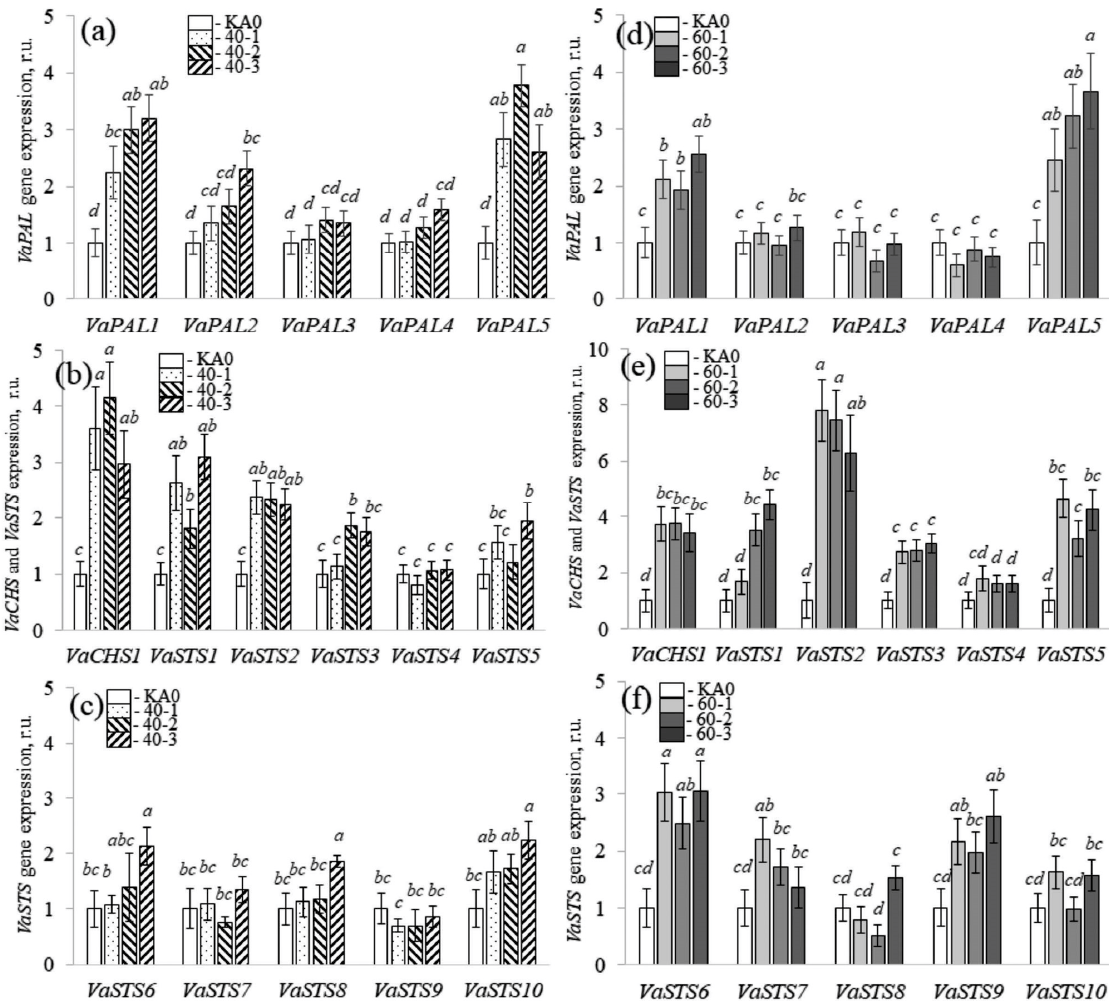
Figure 3. Quantification the VaPAL1-5 , VaCHS1 , and VaSTS1-10 gene expression in the VaMyb40- ( a , b , c ) and VaMyb60 -transgenic ( d , e , f ) cell lines of Vitis amurensis performed by quantitative RT-PCR. Means on each figure followed by the same letter were not different using one-way analysis of variance (ANOVA), followed by the Tukey HSD multiple comparison test (two independent experiments with eight technical replicates). p < 0.05 was considered to be statistically significant.